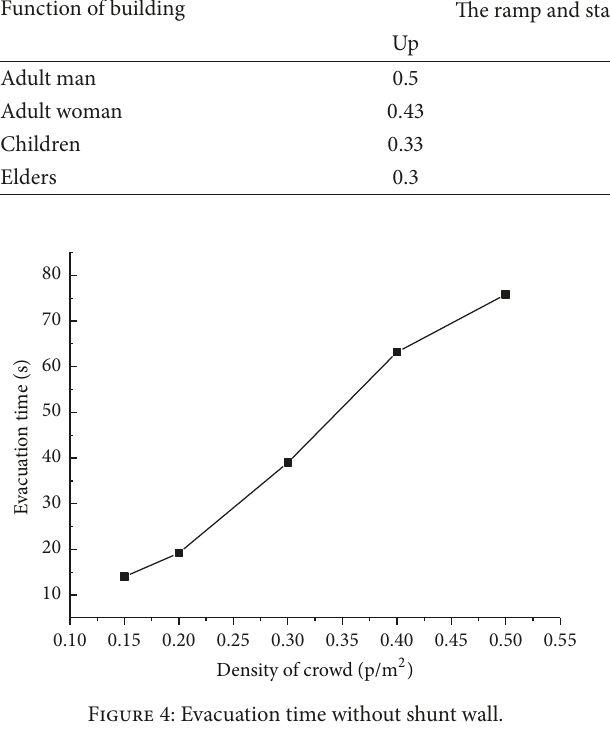
Figure 4: Evacuation time without shunt wall.